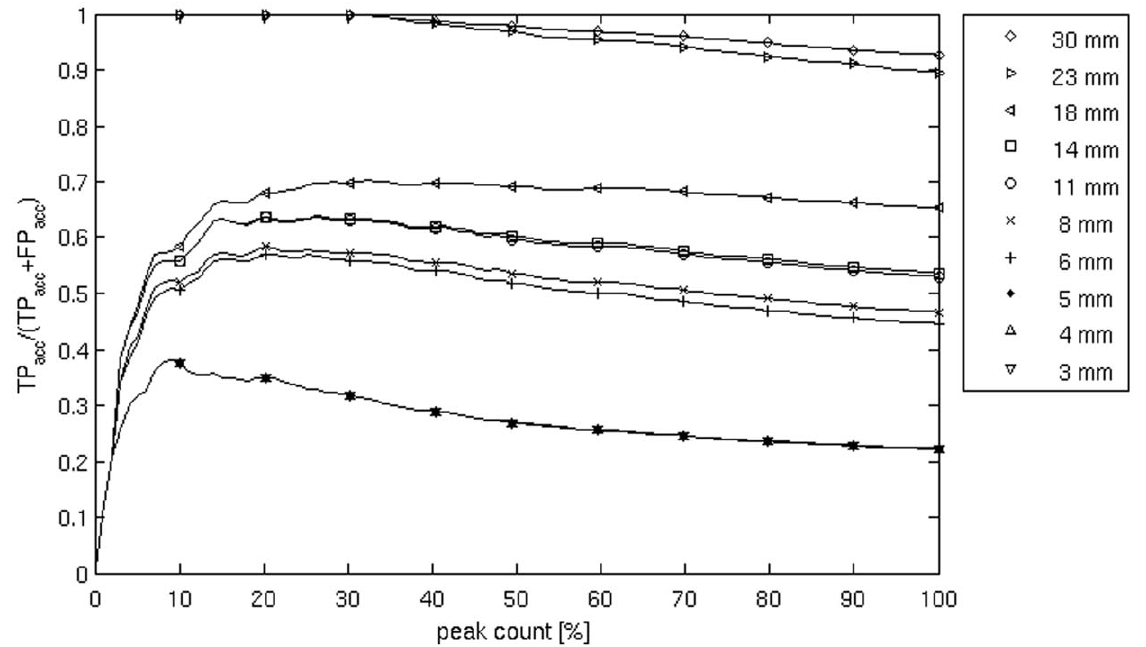
Figure 7. Example of a Positive Predictive Value (PPV) curve for one simulation’s source localization, calculated by means of the localization image volume. The PPV is the proportion of the images peaks that are localized within a given search-size around the simulated dipole (True Positives, TP). Peaks localized outside of the search-size are considered False Positives (FP). Thus, PPV is TP/(TP + FP). The peaks are ordered by intensity, and PPV is calculated for each fraction of the total peak count. In this way, a curve is obtained that indicates whether the stronger peaks fall near the dipole (decreasing slope) or far from it (increasing slope). The area under the curve was used as a performance indicator, the Spatial Accuracy Index (SAI). The curves in the figure depict 10 search-sizes from 3 to 30 mm, on a logarithmic scale.